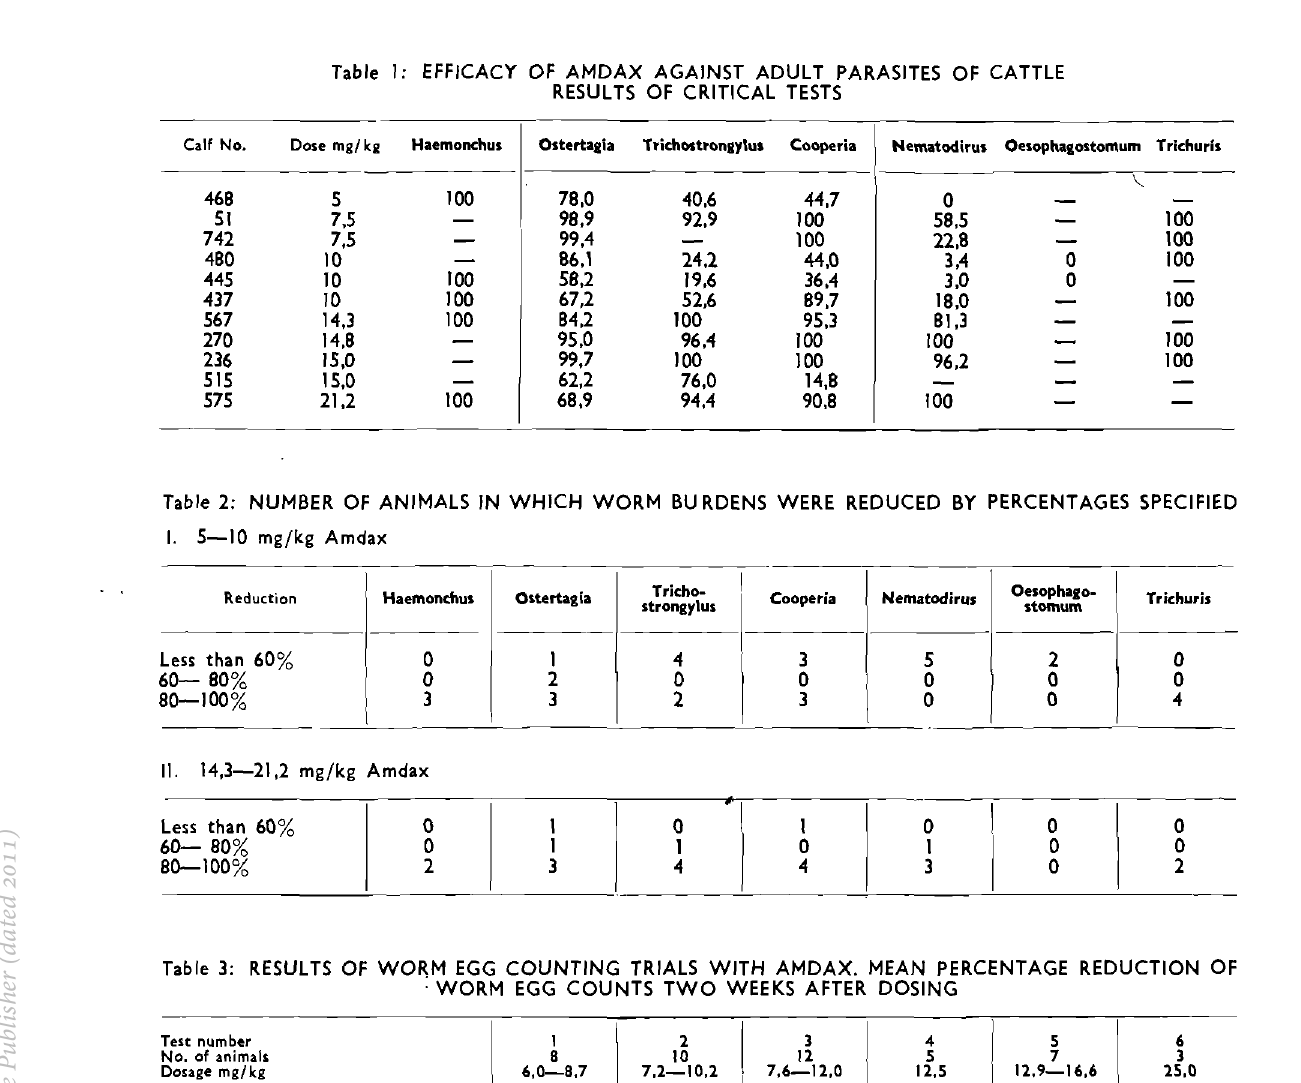
Table 3: RESULTS OF WORM EGG COUNTING TRIALS WITH AMDAX. MEAN PERCENTAGE REDUCTION OF : WORM EGG COUNTS TWO WEEKS AFTER DOSING Test